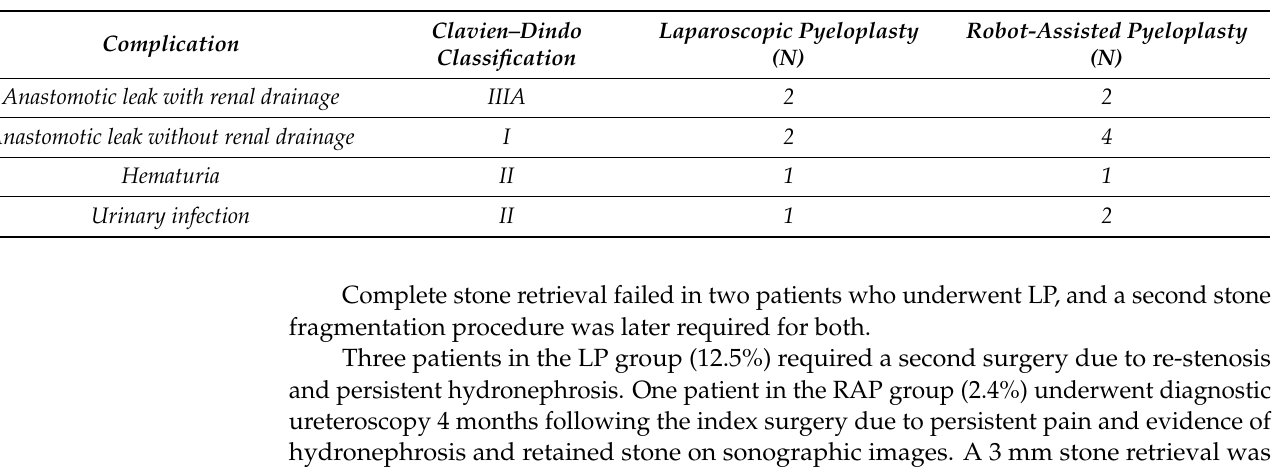
Table 2. Early postoperative complications according to surgical